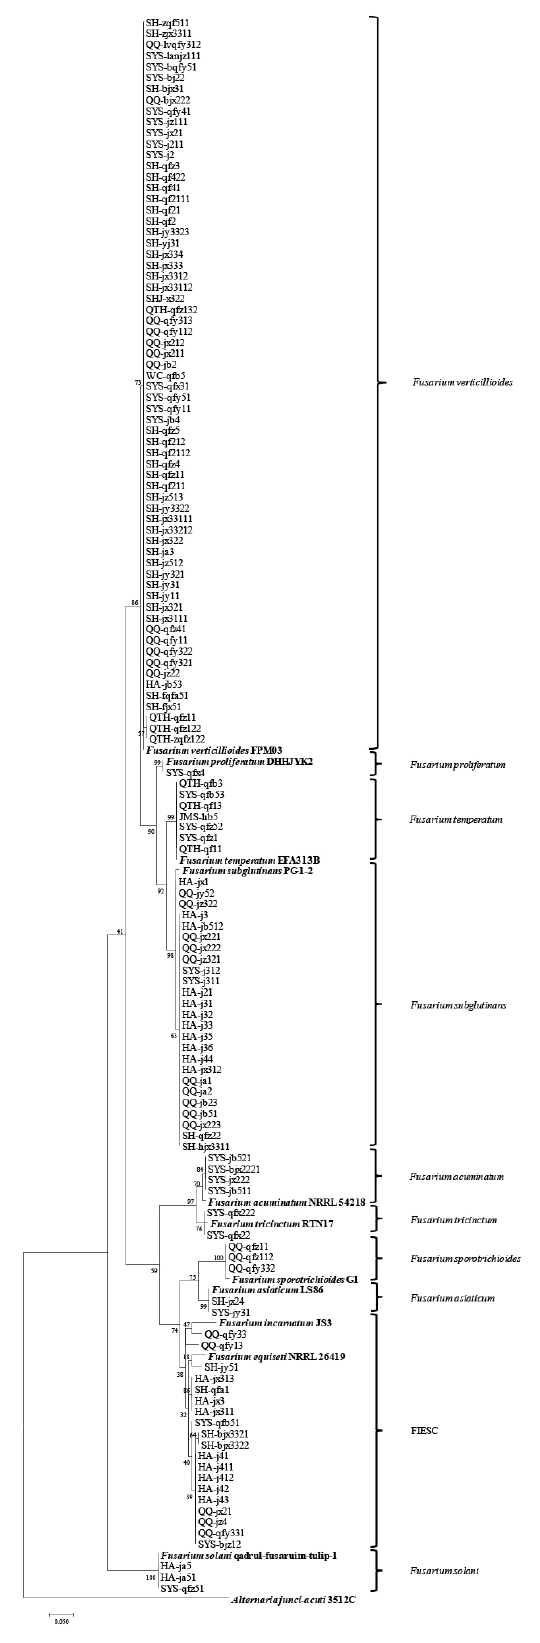
Figure 4. Phylogenetic tree obtained from maximum likelihood analysis based on the TEF-1 α gene